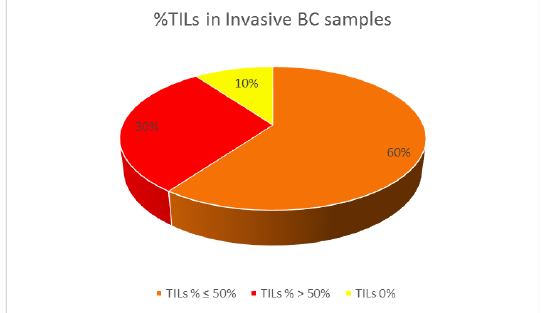
Figure 2. TILs% expression in histological samples of patients with invasive BC (20 patients).